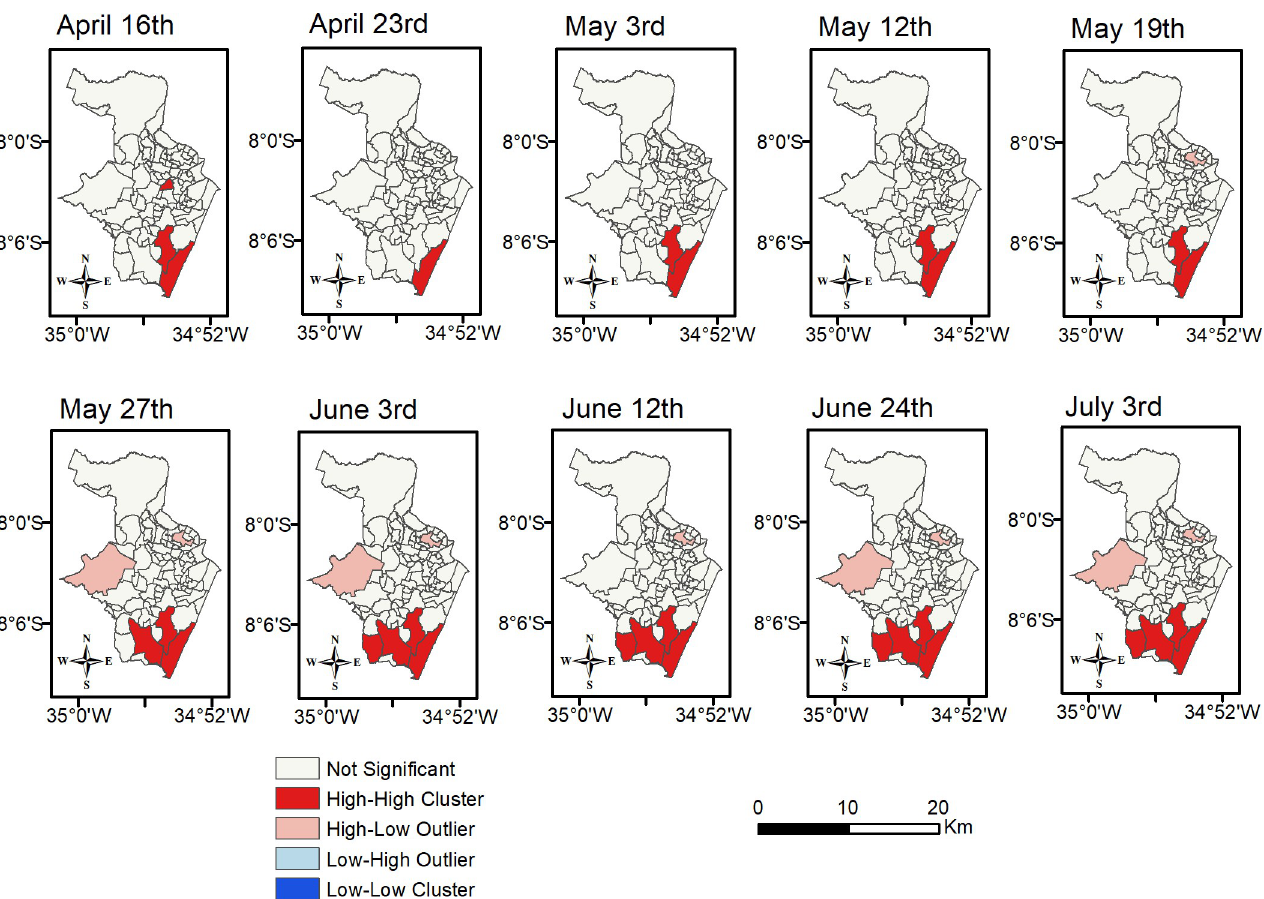
Fig 4. Spatial distribution of cumulative reported COVID-19 cases in Recife at the neighbourhood-level. Sources: Brazilian Institute of Geography and Statistics (IBGE) 2021, and software ArcGIS 10.4.1.